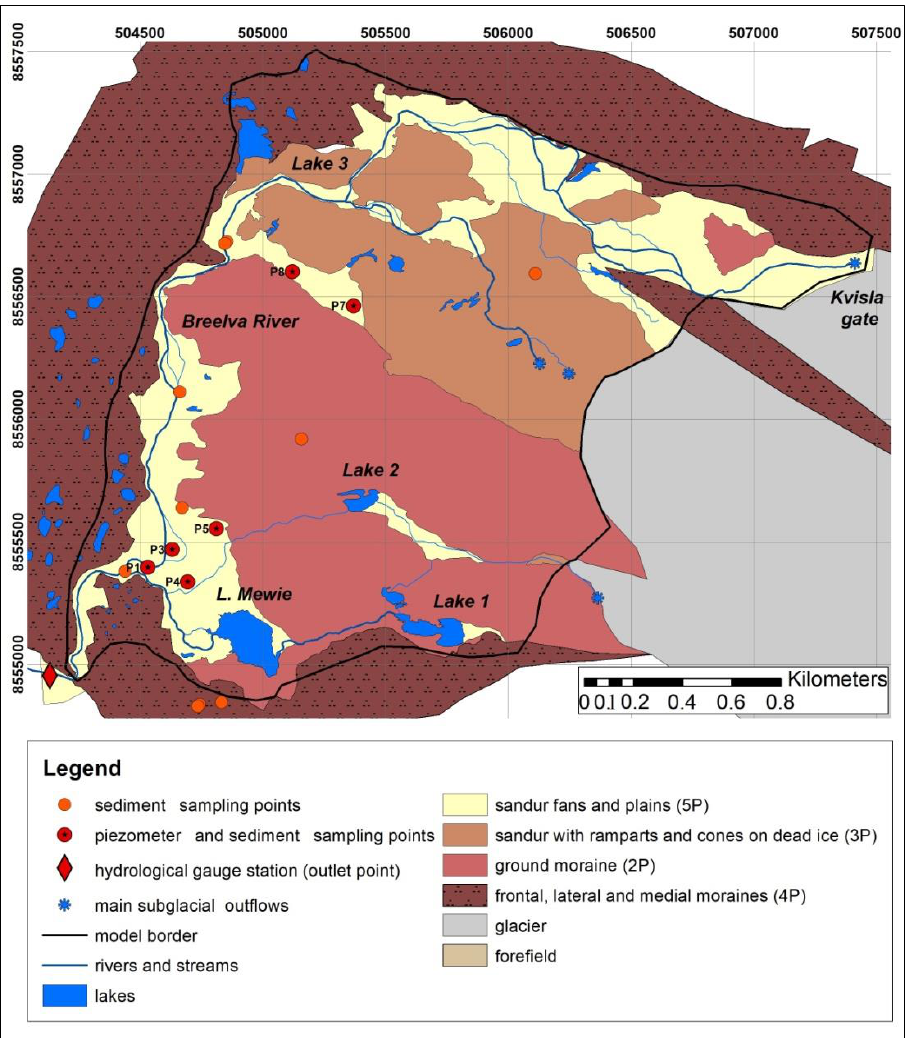
Figure 2. The Werenskioldbreen forefield and simplified geomorphology based on an orthophotomap, a geomorphological map [49] and a map from Norwegian Polar Institute Map Data and Services. Scheme 2P – 5P is the numbering of geomorphological polygons.